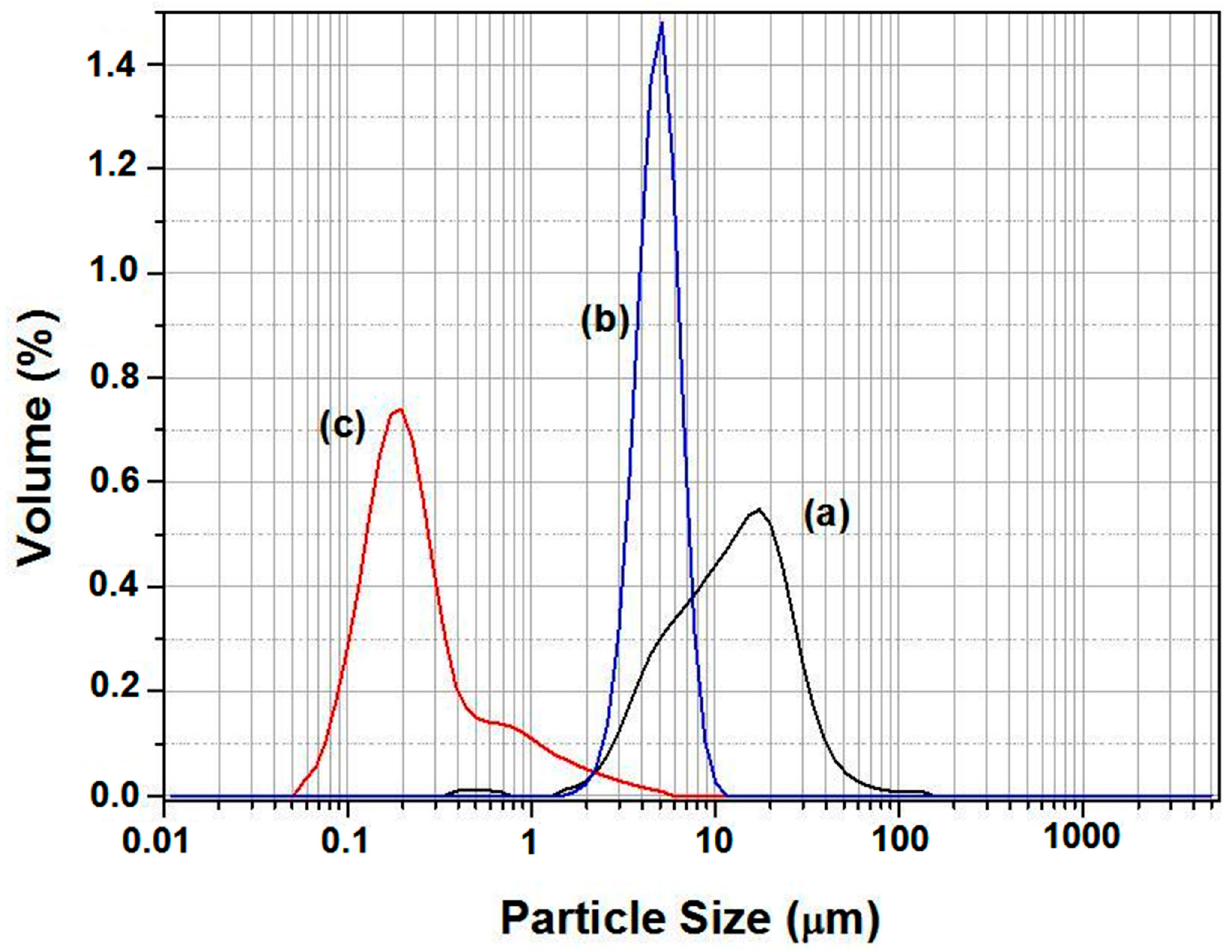
Figure 3. Particle size distribution for SS (a), CC powder sand (b), and zirconium silicate powders (c). Table 1. Chemical compositions of raw materials, expressed as weight percentage, for the different oxides (obtained with the X-ray fluorescence technique).